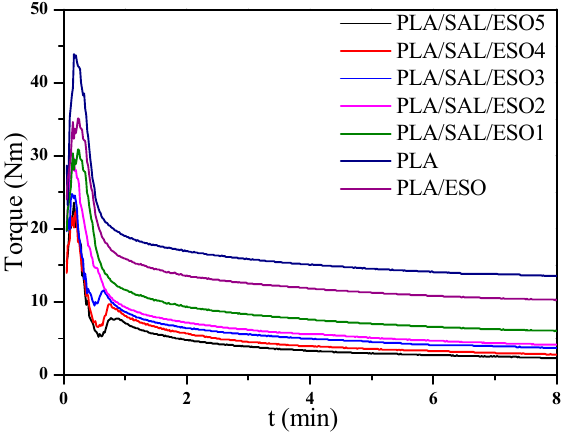
Figure 5. Torque-time curves for dynamic vulcanization of PLA, SAL, and ESO.